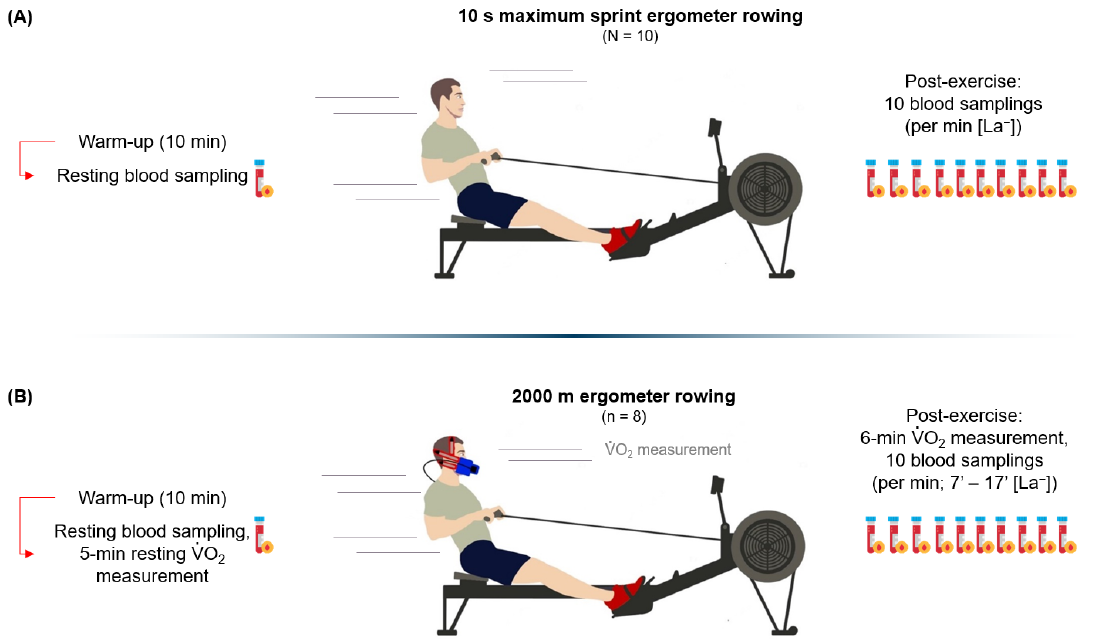
Figure 1. Rowing time trial (RTT) and rowing sprint test (RST) test procedures. ( A ) Procedure of the 10 s RST and ( B ) 2000 m RTT.